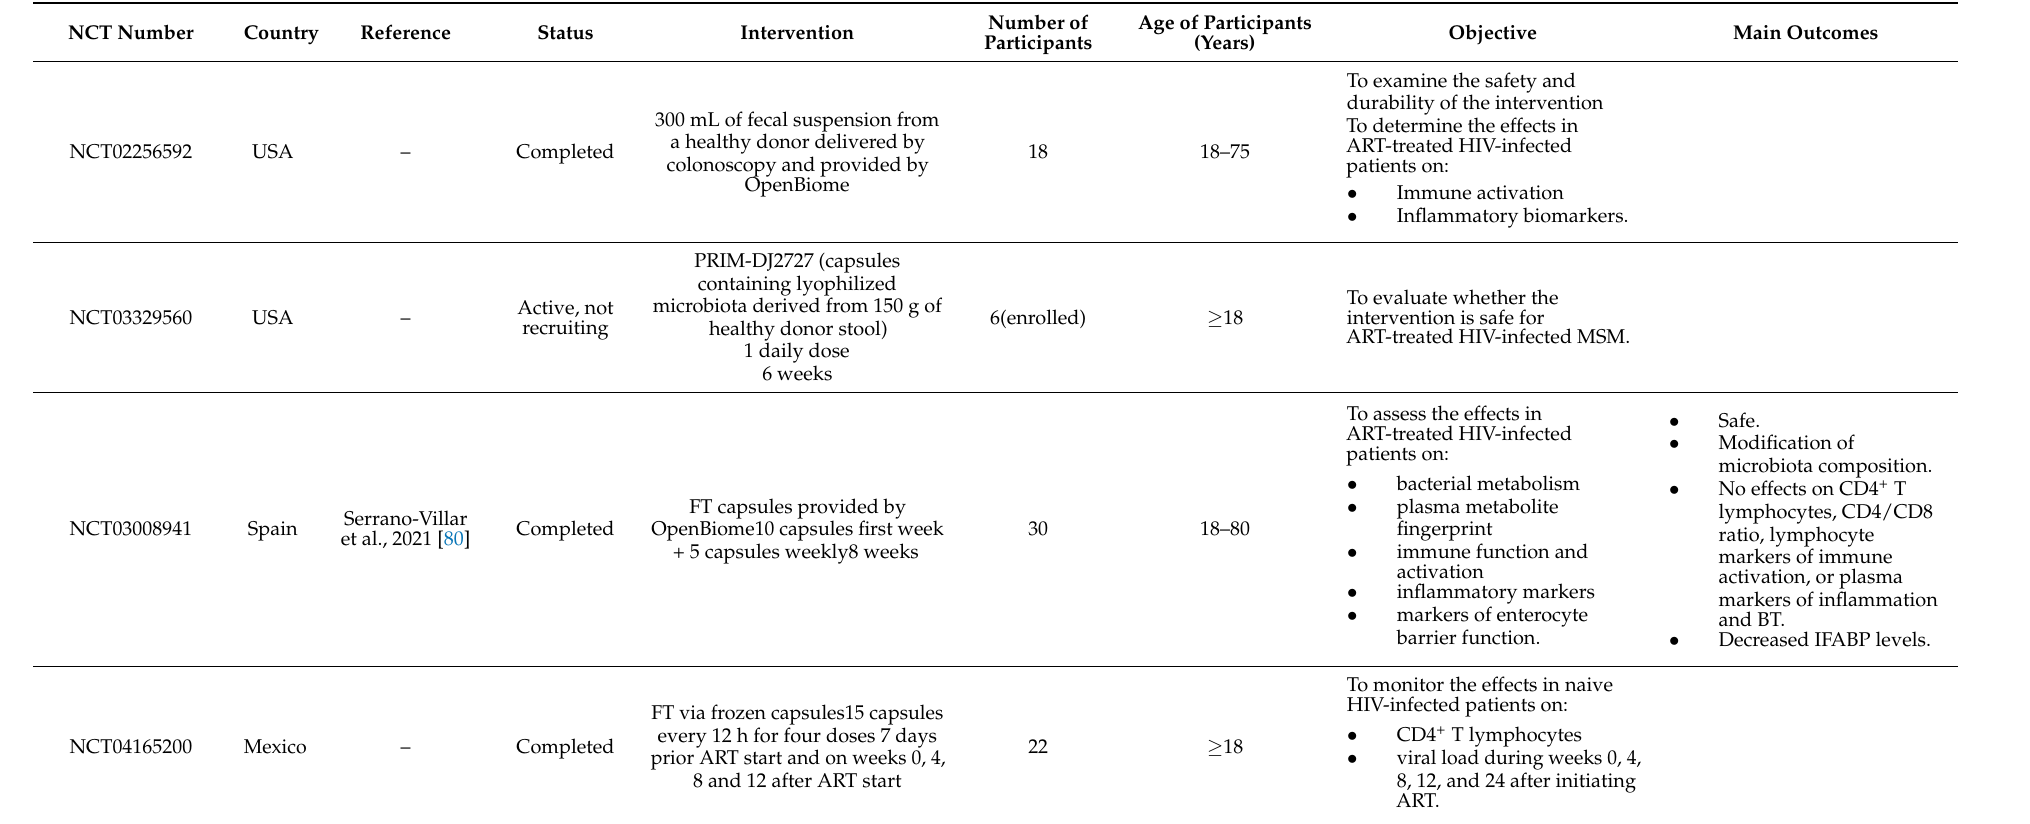
Table 5. Clinical trials concerning fecal transplantation registered in